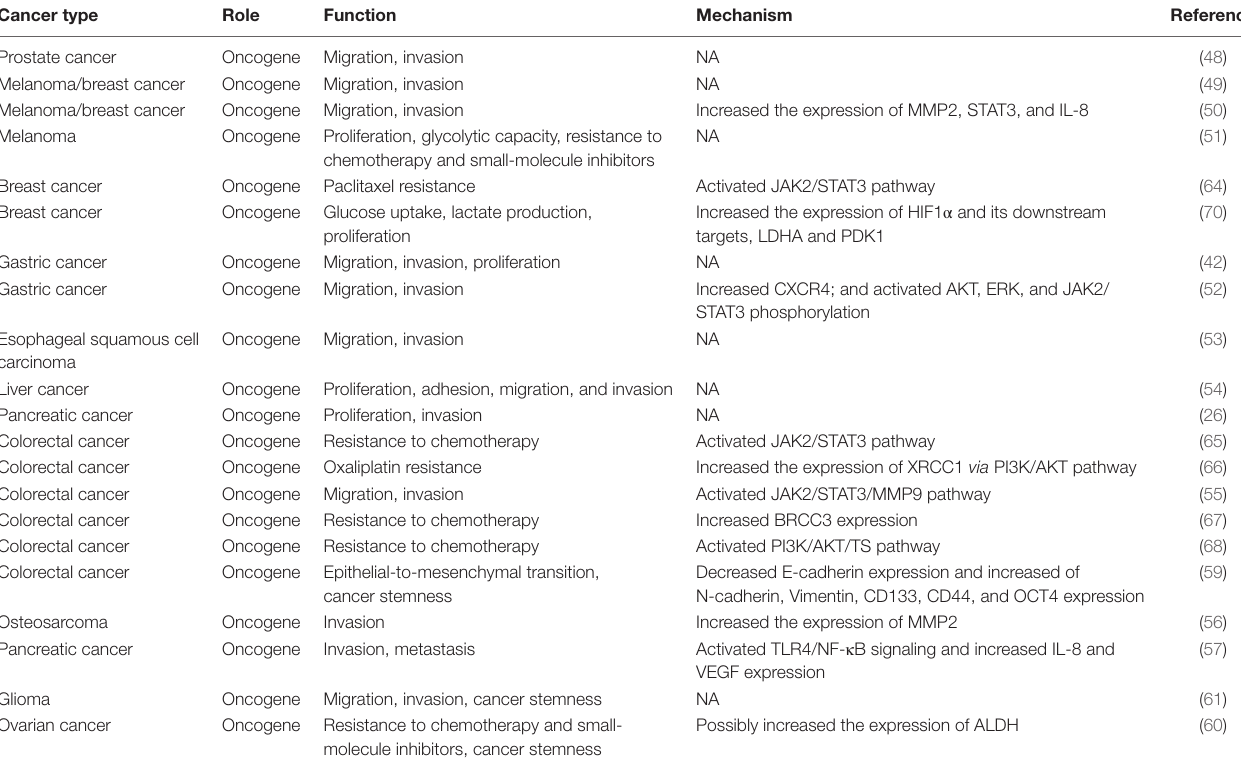
TABle 2 | Roles, functions, and mechanisms of B7H3 in